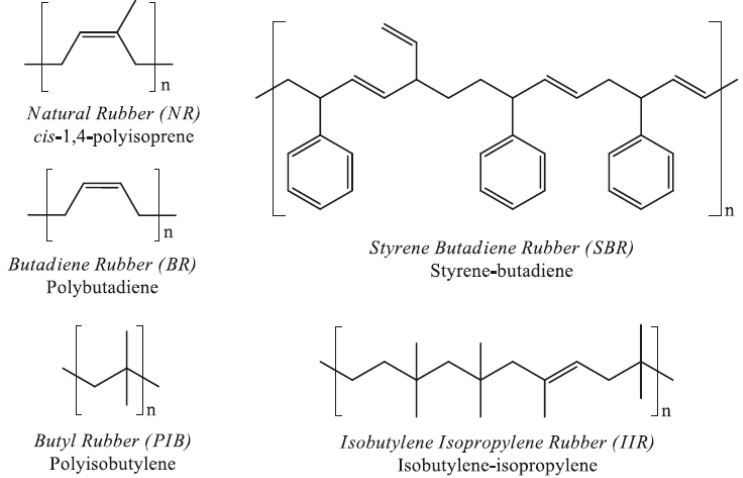
Figure 2. Chemical structure of rubbers used in tire composition (reproduced with permission from [28]).